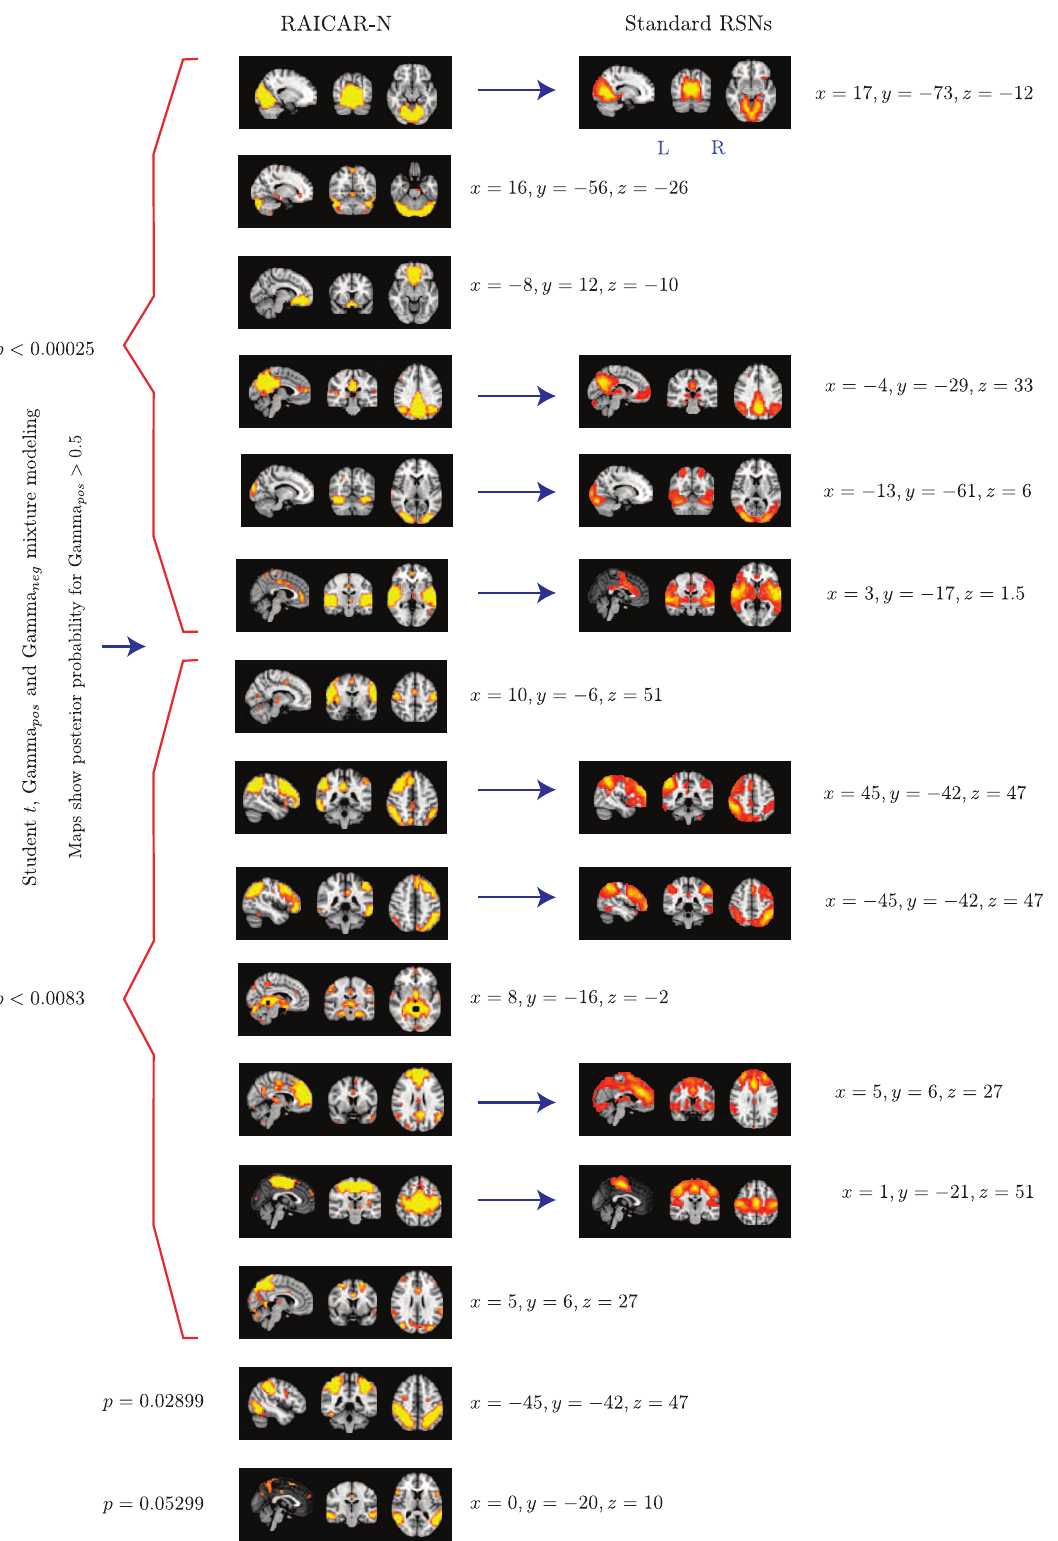
Figure 11. The top 15 ‘‘reproducible’’ ICs from K ~ 50 runs of L ~ 5 subject group ICA RAICAR-N analysis compared with standard RSN maps reported in literature [ 8 ] . We are able to declare 8 ‘‘standard’’ RSNs as significantly reproducible at a p -value of v 0 : 05 . There are 6 other ‘‘non-standard’’ RSNs that can be declared as significantly reproducible at a p -value of v 0 : 05 and 1 other ‘‘non-standard’’ RSN that achieves a p - value of 0 : 05299 .